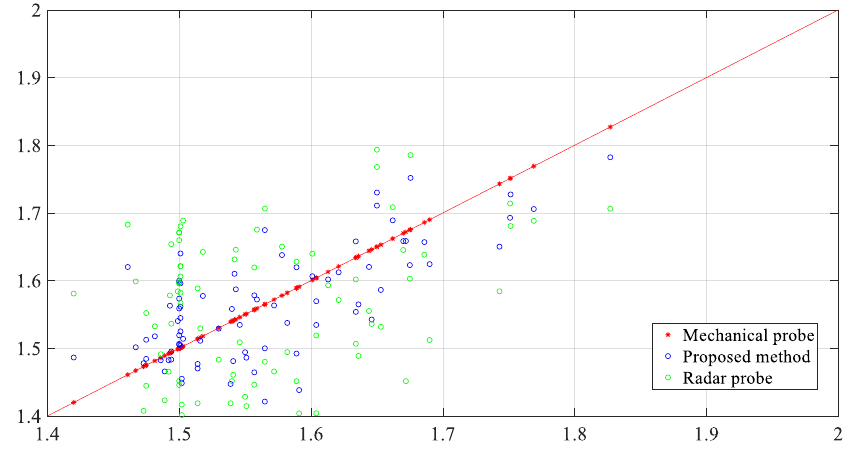
Figure 19. 45 ◦ line graph and comparison with radar Figure 19. 45° line graph and comparison with radar probe.